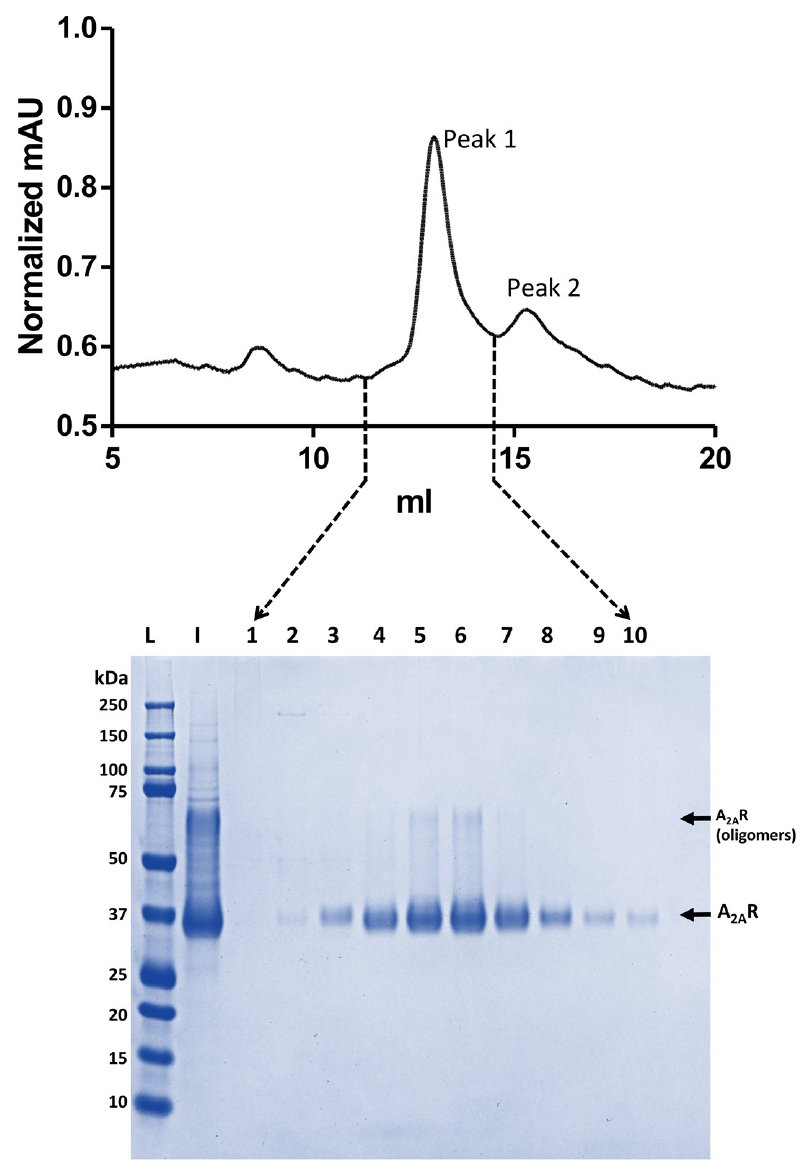
Figure 1. Size exclusion chromatography profile of the detergent solubilised adenosine type 2A